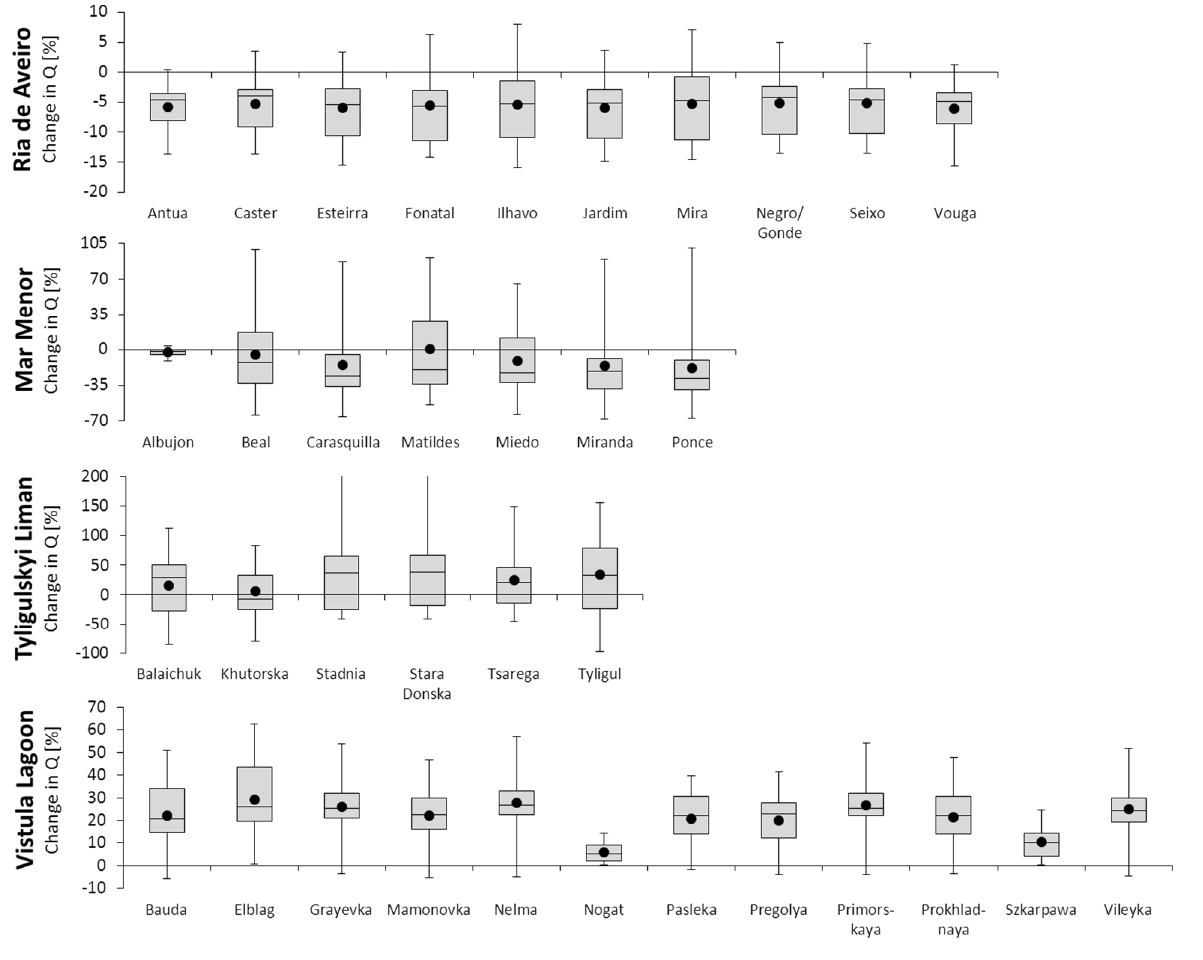
Figure 5. Percental changes in long-term average annual discharge of the main tributaries entering the four lagoons under study comparing the intermediate future period p2 (2041–2070) and the reference period p0 (1971–2000). The box plots visualize min/max, 25/75-percentiles, median (line) and average (dots) values based on simulated results driven by 15 ENSEMBLES